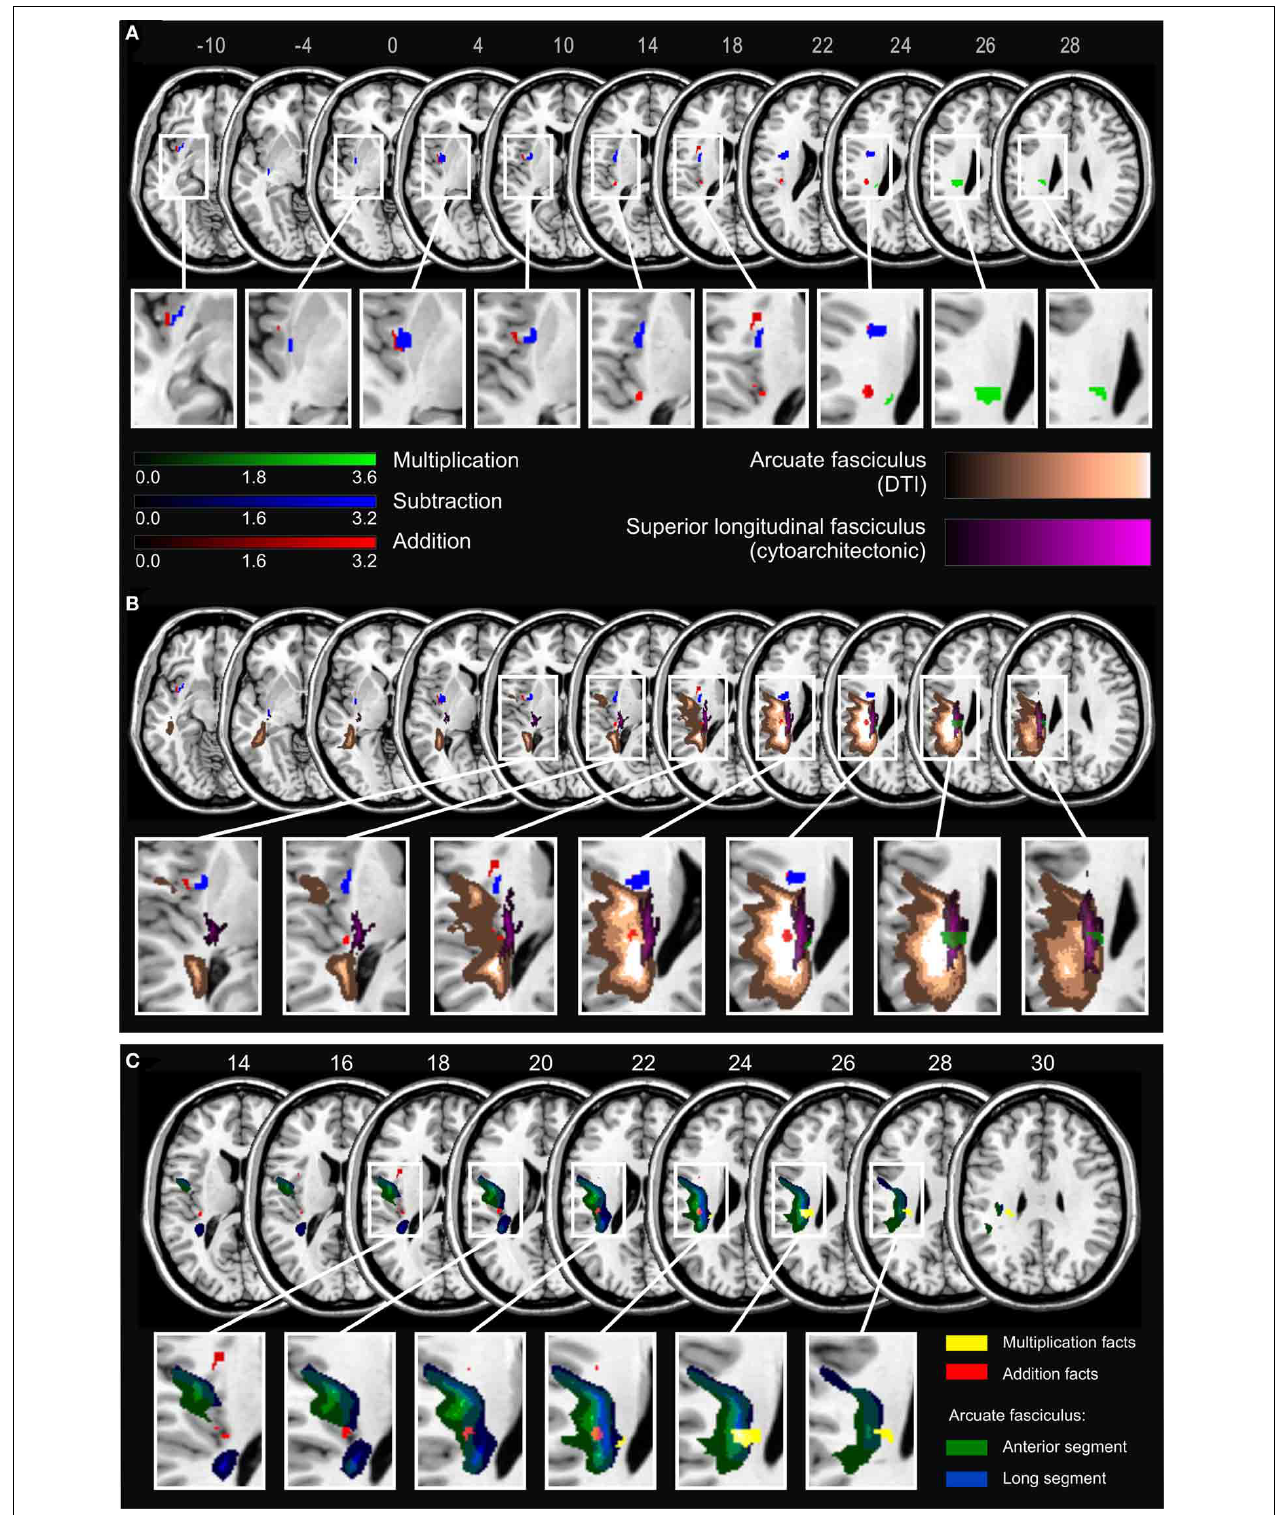
FIGURE 2 | (A) Statistical voxel-wise lesion-behavior mapping (VLBM) analyses using the Liebermeister-test statistic for the dichotomous deficit yes/no-criterion in the three arithmetic tasks in 21 LHD patients. Plotted are voxels that survived a permutation-test based